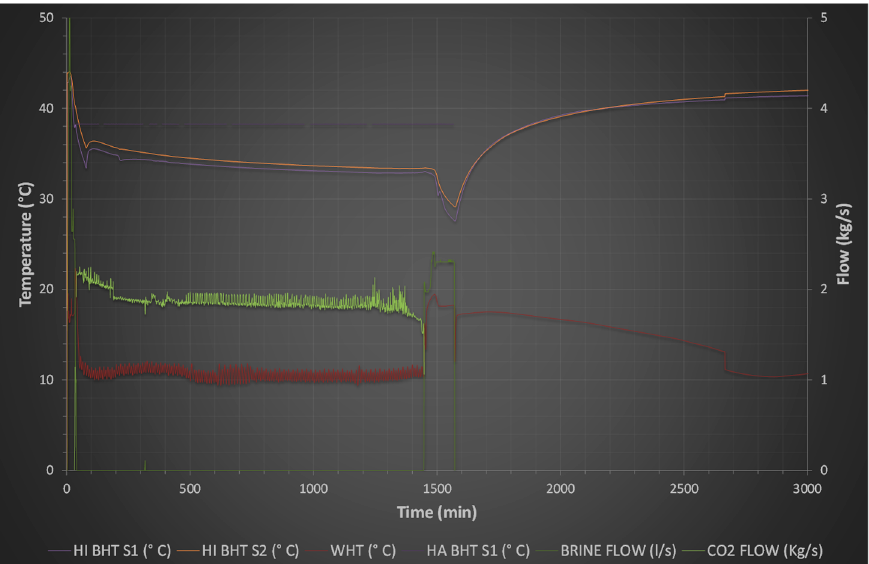
Figure 6. The evolution of the BHT and WHT of the 24-hour CO 2 injection test in the pressure control mode (80 bar). The BHT data from sensors of the HI well ( HI BHT S1/S2 ), the WHT in the injection well, the BHT in the sensor located in the seal of the HA well ( HA BHT S1 ) and the flow rates of brine and CO 2 .